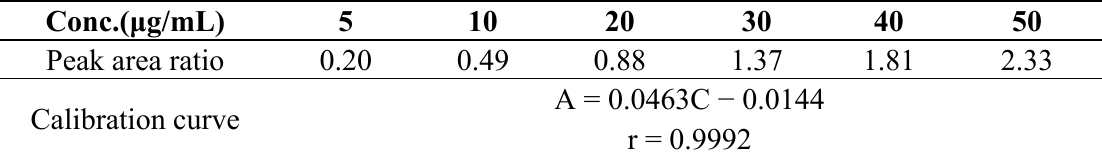
Table 1. The linearity result of ( S )-modafinil by the established